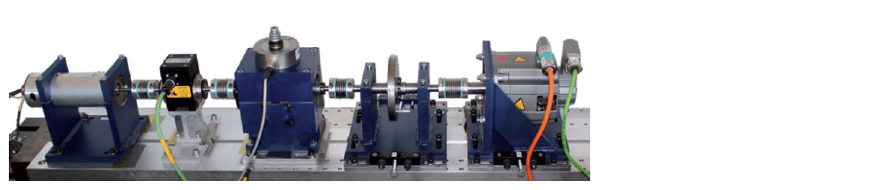
Figure 10. Mechanical setup of the test